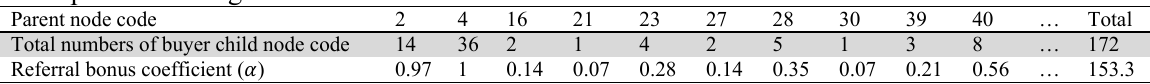
A sample of resulting X for each